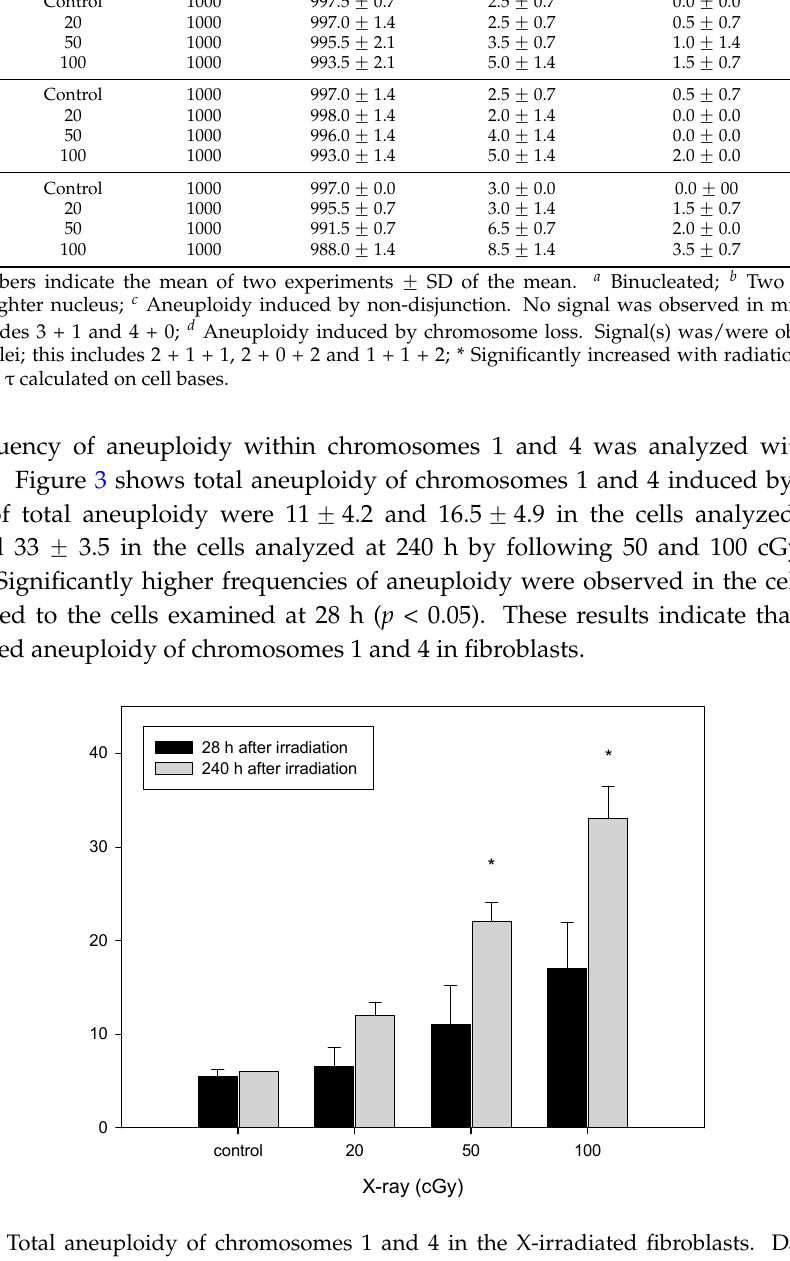
Table 3. The frequency of different types of aneuploidy in chromosome 4 from X-irradiated fibroblasts. Time after Irradiation (h)